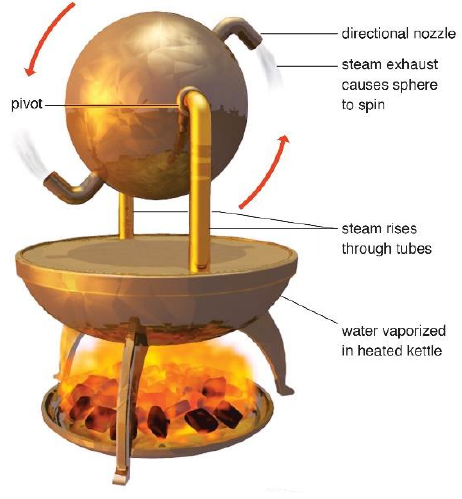
Figure 8. Hero ’ s aeolipile [54]. Figure 8. Hero’s aeolipile